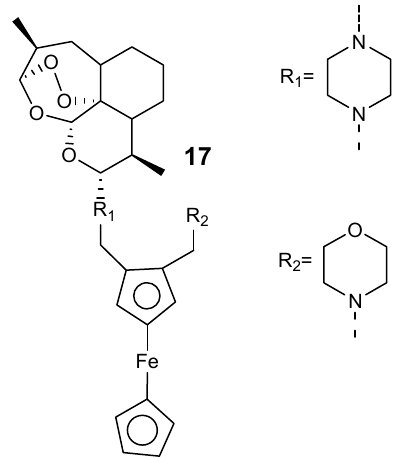
Figure 5. Artemisinin–ferrocene hybrid compounds ( 17 ).